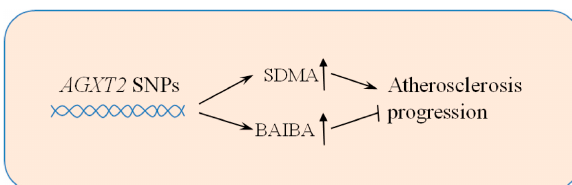
Figure 4. Potentially protective effect of BAIBA on atherosclerosis progression in human subjects with functional AGXT2 SNPs. AGXT2 functional SNPs associate with elevation in plasma concentration of both its substrates, SDMA and BAIBA, that oppositely affect atherosclerosis development and cardiovascular outcomes in humans. AGXT2—alanine:glyoxylate aminotransferase 2, SNPs—single nucleotide polymorphisms, SDMA—symmetric dimethylarginine, BAIBA— β -aminoisobutyric